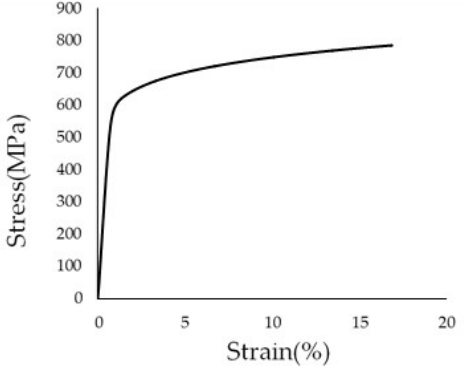
Figure 9. Continuous yielding behavior of low-carbon boron-bearing steel deformed asymmetrically at a rolling temperature of 790 °C.